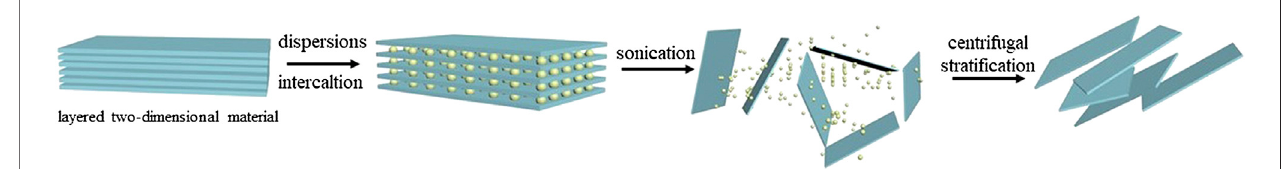
FIGURE 6 | Liquid phase exfoliation.